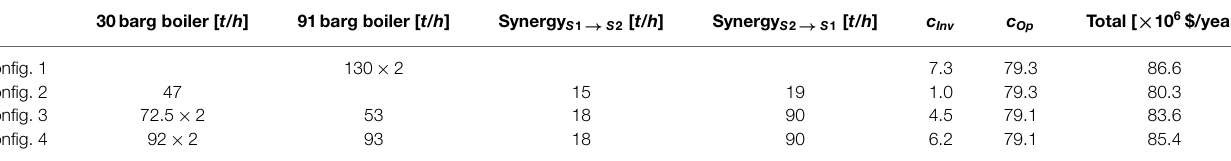
TABLE 4 | Proposed investments to replace old CB boilers